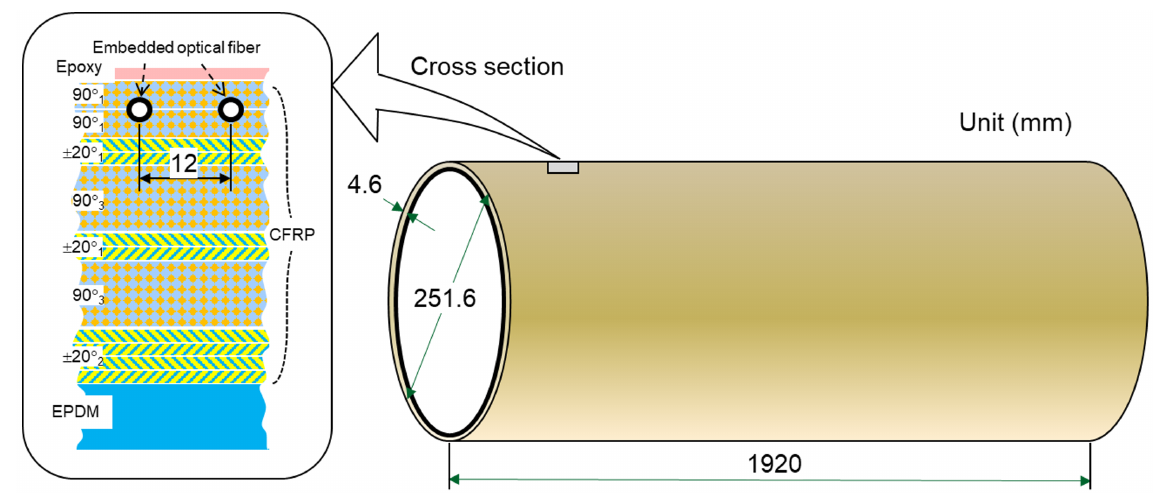
Figure 1. Schematic of an optical fiber embedded composite cylinder.